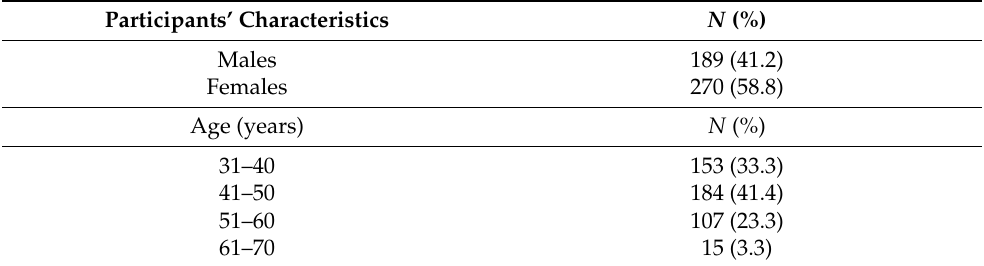
Table 2. Respondents’